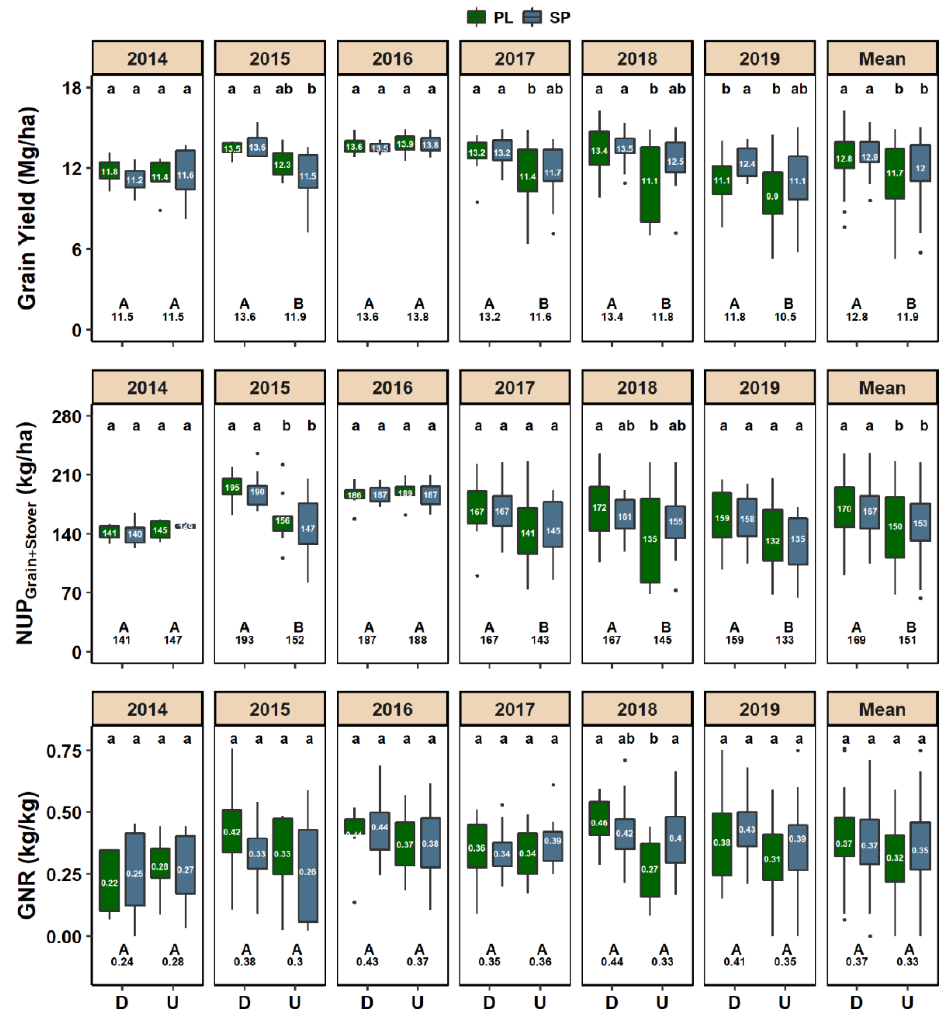
Figure 3. Distribution of grain yield, nitrogen uptake in the grain and stover (NUP Grain+Stover ), and grain nitrogen recovery (GNR) in drained (D) and undrained (U) conditions averaged across nitrogen fertilizer rates (90, 135, 179, and 224 kg N ha − 1 ) applied at planting (PL) or split applied (SP) (45 kg N ha − 1 at planting and the remaining at V6 to V8) for different years and across years. Numbers inside the boxplots indicate the means for PL and SP within drainage condition and year. Numbers in the bottom indicate the overall mean for D and U within year. Lower case letters on top denote significant differences ( p < 0.1) between application timing and drainage condition within year. Upper case letters in the bottom denote significant differences ( p < 0.1) between drainage condition within